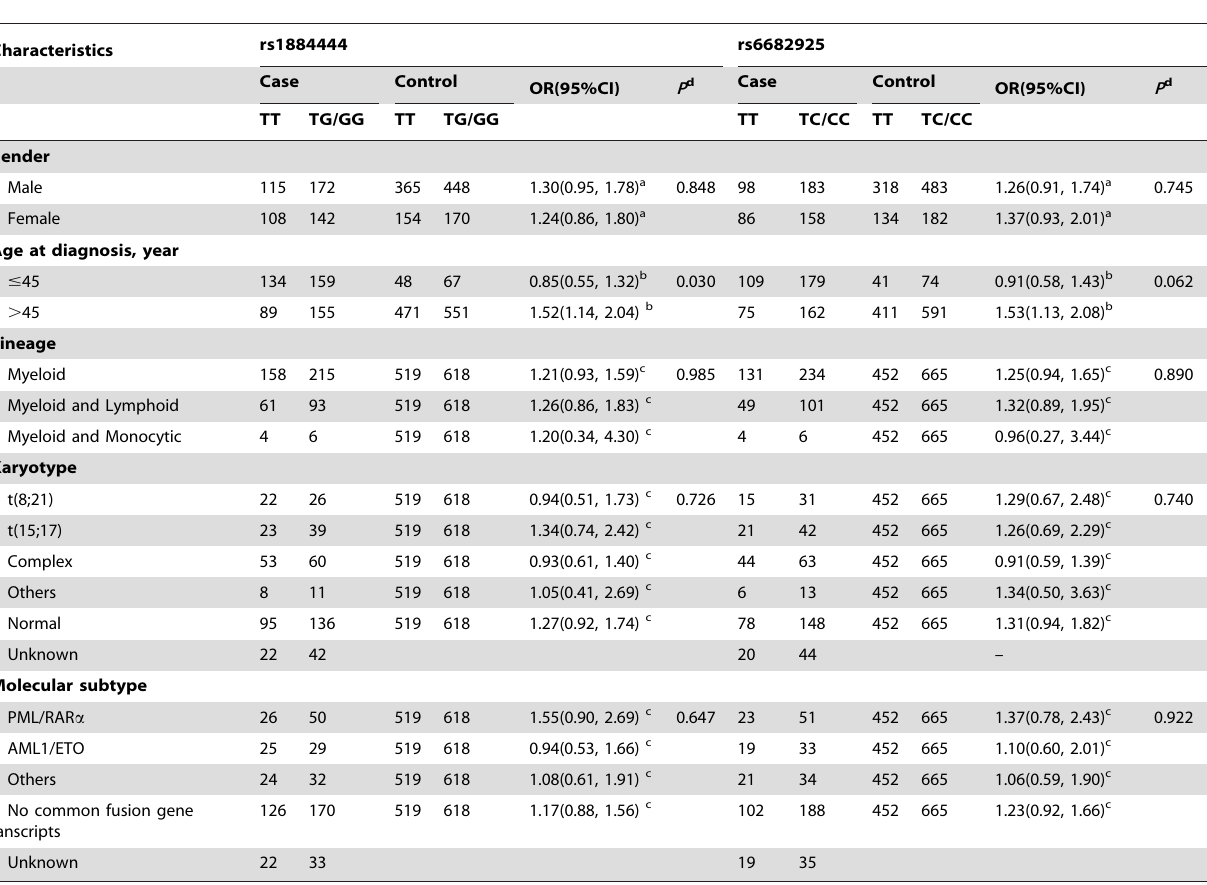
Table 3. Stratification Analysis of rs1884444 and rs6682925 Genotypes by Selected Variables in AML Patients and Controls.